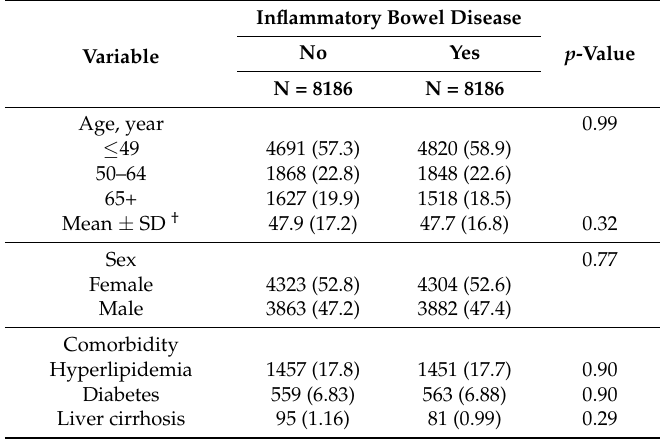
Table 1. Demographic characteristics and comorbidities in the cohorts with and without inflammatory bowel